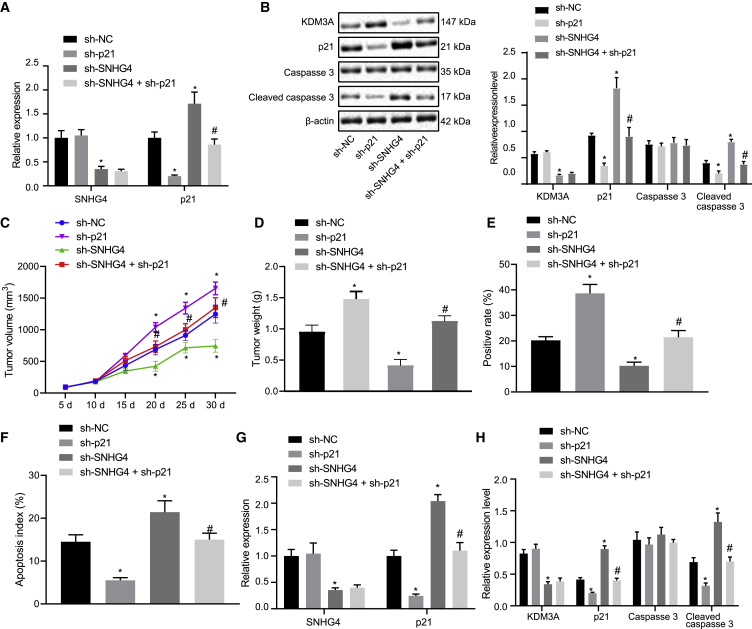
lncRNA SNHG4 promoted the tumorigenicity of human NSCLC cells in vivo by increasing KDM3A and p21 expression(A) Verification of lncRNA SNHG4 and/or p21 knockdown by qRT-PCR. (B) Western blots and quantification of KDM3A, p21, cleaved caspase-3, and caspase-3 in H1299 cells, normalized to β-actin expression. (C) The growth of mouse xenotransplanted tumors of H1299 cells at indicated time points. (D) Weight of mouse xenotransplanted tumors of H1299 cells. (E) Ki67-positive cells detected by immunohistochemical staining. (F) Cell apoptosis detected by TUNEL staining. (G) lncRNA SNHG4 and p21 expression detected by qRT-PCR. (H) Western blot analysis of KDM3A, p21, cleaved caspase-3, and caspase-3 in tumor tissues, normalized to β-actin expression. ∗p < 0.05 (compared with mice treated with scramble shRNA) and #p < 0.05 (compared with mice treated with lncRNA SNHG4-specific shRNA) by Tukey’s test-corrected one-way ANOVA or Bonferroni-corrected repeated-measures ANOVA.